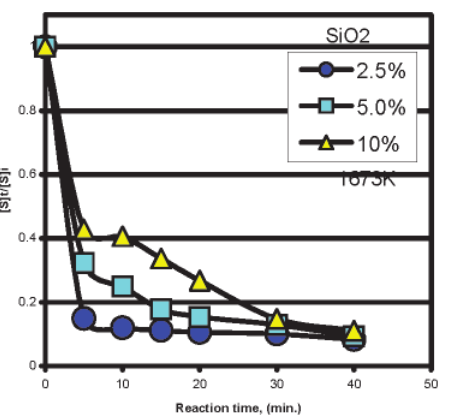
Fig. 6: Effect of SiO 2 in calcium aluminate fluxes on hot metal desulphurization.